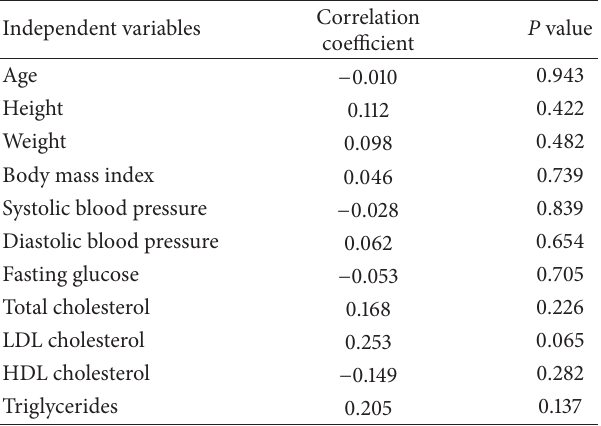
Table 2: Average CIMT Correlation